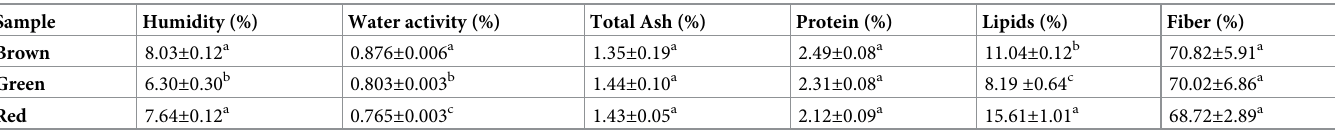
Table 1. Determination of the content of humidity, water activity, total ash, raw protein, total lipids and fiber of brown, green and red propolis samples.